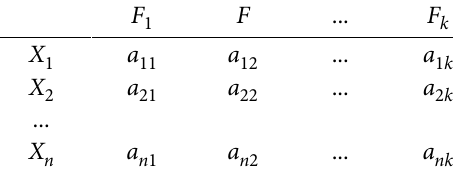
Figure 2. Model factor analysis